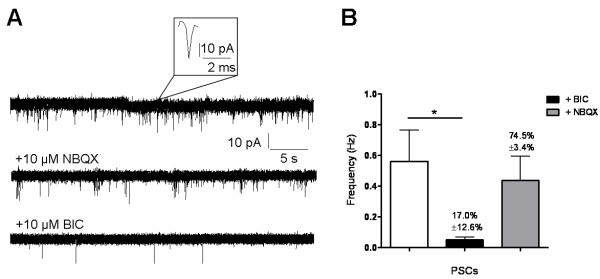
Differentiated hCBiPSC exhibited spontaneous synaptic activity. (A) Current traces recorded in whole-cell voltage-clamp mode from a single cell of the hCBiPSC line K2 under control conditions (top) and following application of the AMPA receptor blocker NBQX (10 μM, middle) or the GABAA receptor blocker bicuculline (BIC, 10 μM, bottom). (B) Average frequency of spontaneous post-synaptic currents (PSCs). Application of BIC significantly reduced the PSC frequency to 17.0% (n = 5), NBQX just slightly depressed PSCs to 74.5% (n = 5). hCBiPSC, human cord blood induced pluripotent stem cells.